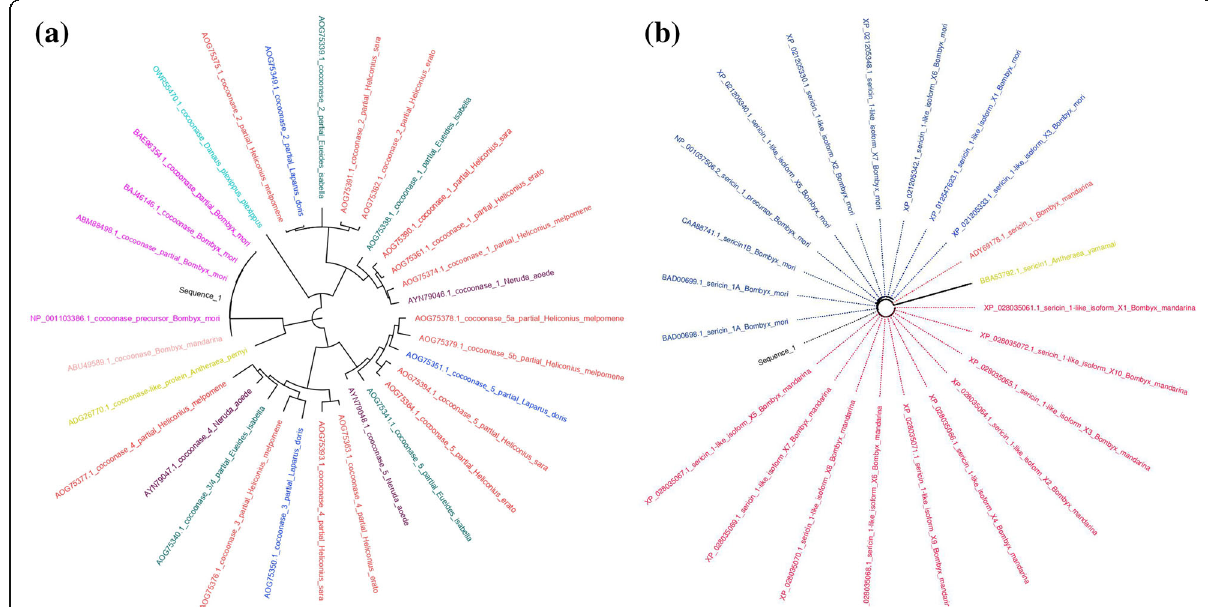
Fig. 1 The phylogenetic tree of cocoonase ( a ) and sericin ( b ) that was constructed using MEGA X [39]. The evolutionary history was inferred by using the Maximum Likelihood method and JTT matrix-based model [32]. The tree with the highest log likelihood of − 5997.87 is shown in ( a ) and − 10557.91 in ( b